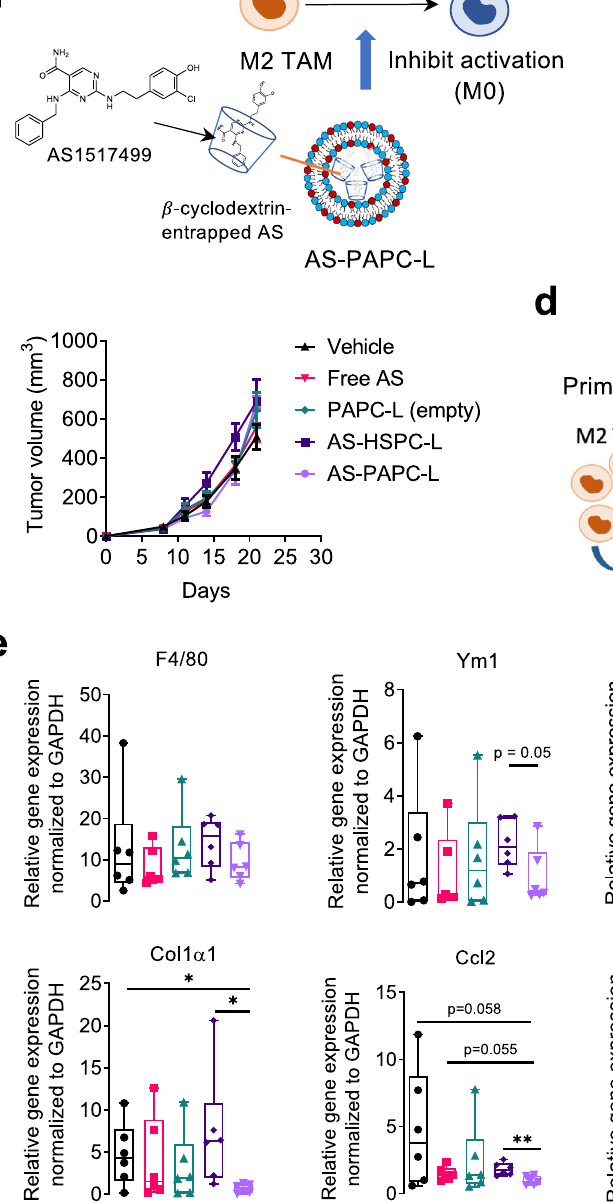
illustrating the premetastaticniche formationinlungs. M2TAMssecrete cytokines which activate tumor cells and in response of that tumor cells secrete factors